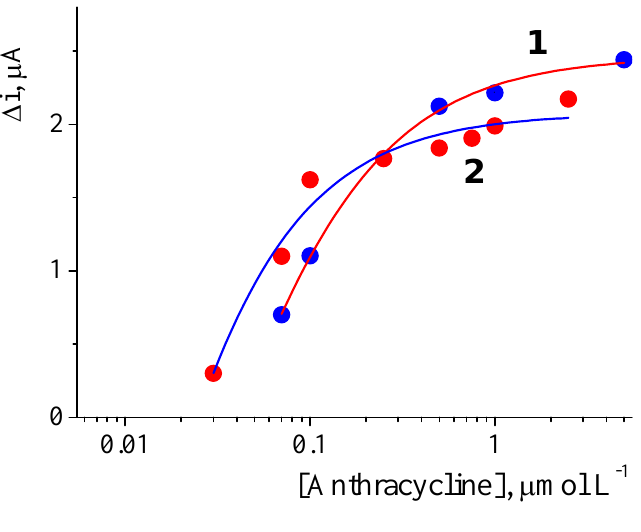
Figure 4. The influence of doxorubicin (1) and rubomycin (2) on the MB signal recorded